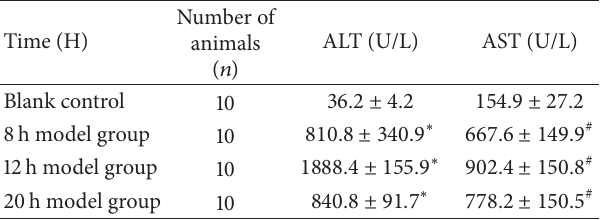
Table 2: Mortality changes in ConA-induced hepatic injury. Group